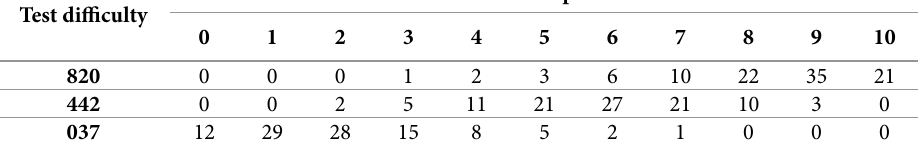
Test difficulty